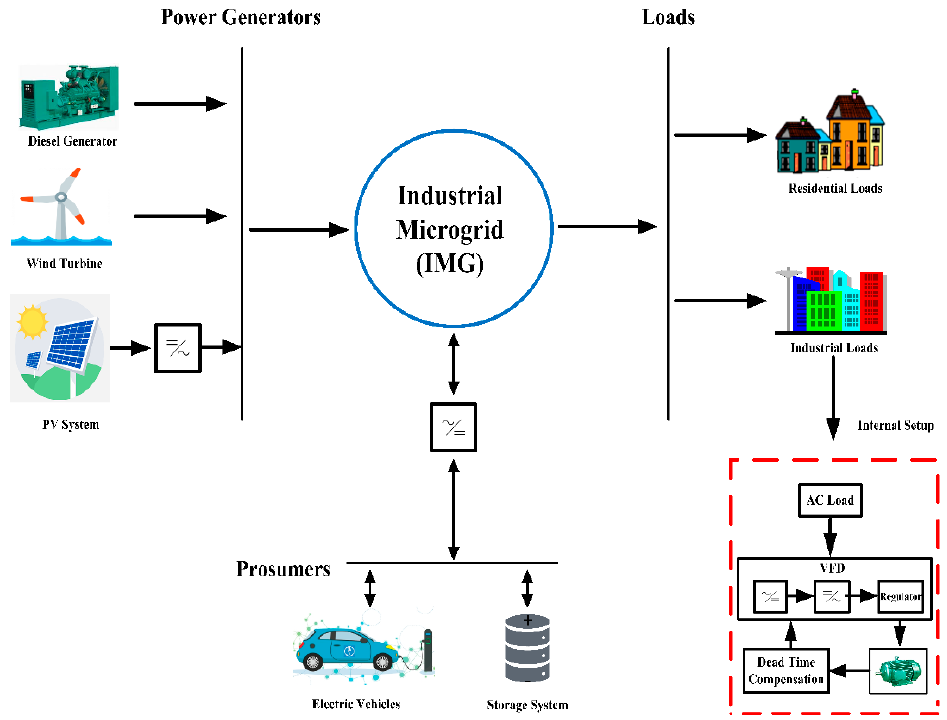
Figure 1. Conceptual view of an Industrial Microgrid.